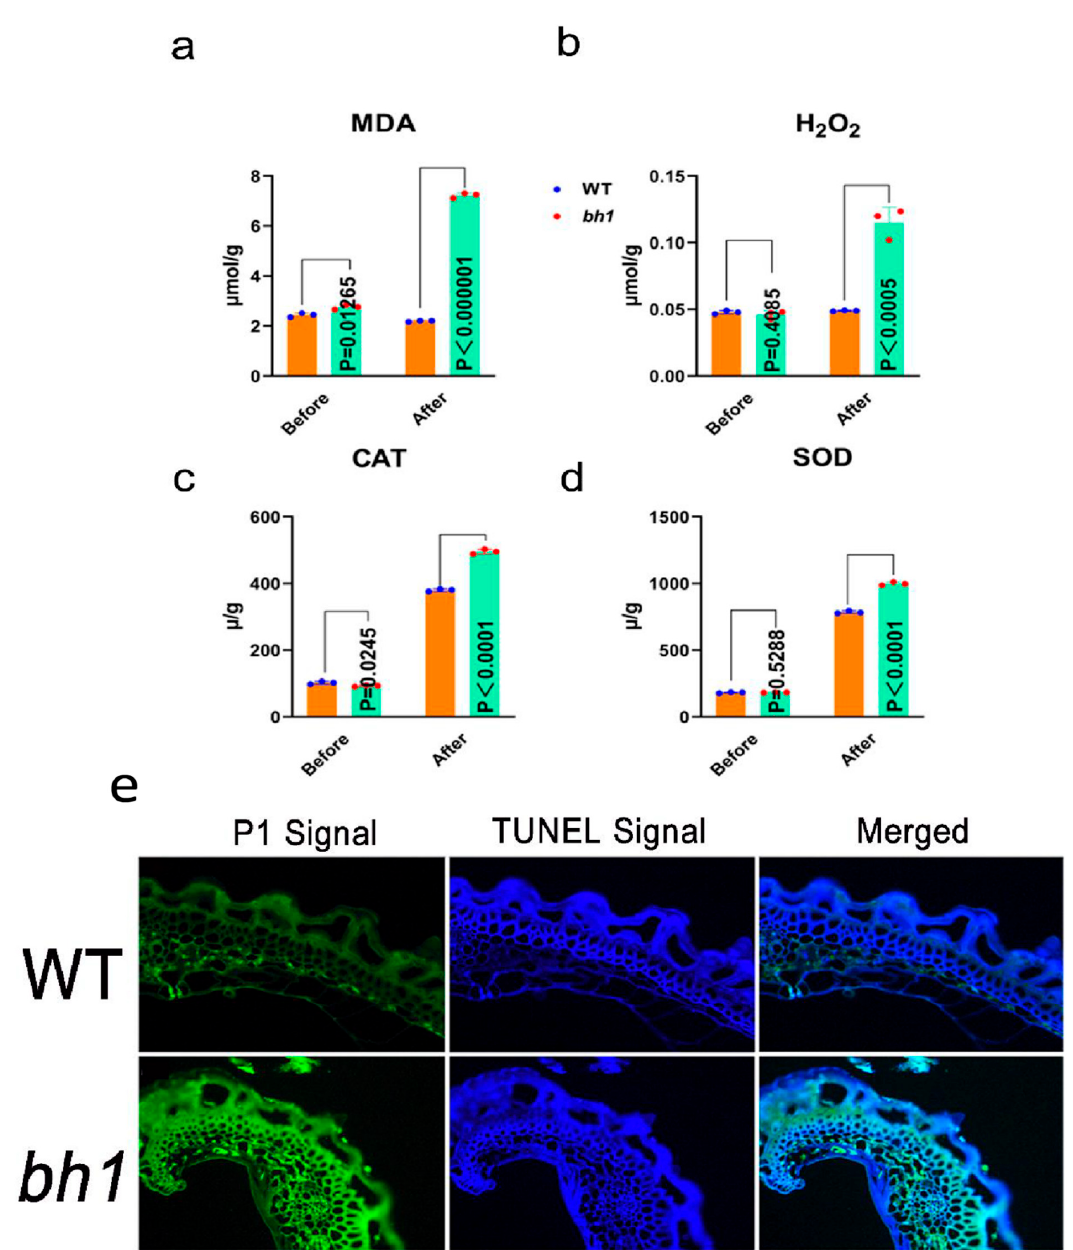
Figure 3. Comparison of reactive oxygen species (ROS) in the hulls of brown hull1 (bh1) and Wild type (WT). ( a ) Determination of malondialdehyde, ( b ) hydrogen peroxide, ( c ) catalase ( d ) superoxide dismutase contents in hulls of WT and bh1 ( e ) TUNEL assay showing DNA fragmentation in hulls of WT and bh1 . Propidium iodide (PI) produces green fluorescence in the tissues of hulls, while a merged view (blue and green fluorescence) displays the positive signals of TUNEL. 2.4. Genetic Analysis Reveals a Cytoplasmic Os1 β Glu4 Encodes bh1 Phenotype For genetic analysis of bh1, two mapping populations were constructed by crossing bh1 with WT ( indica ) and 02428 ( japonica ). In both populations, all F 1 plants showed normal white-straw hulls, however, some F 2 plants showed brown pigmentation on hulls with a segregation ratio of 3:1 ( χ 2 = 0.64 < χ 20 . 05 = 3.57). The segregation ratios showed that a single